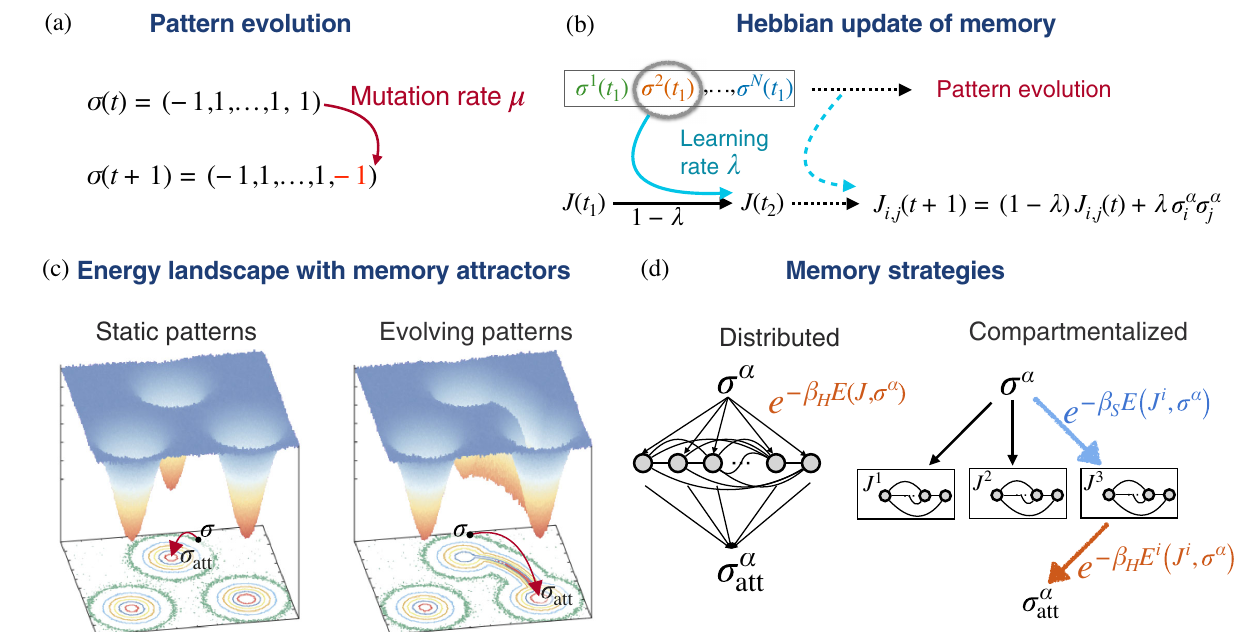
FIG. 1. Model of working memory for evolving patterns. (a) The targets of recognition are encoded by binary vectors f σ g of length L . Patterns can evolve over time with a mutation rate μ denoting the fraction of spin flips in a pattern per network update event. (b) Hebbian learning rule is shown for a network J , which is presented a set of N patterns f σ α g (colors) over time. At each step, one pattern σ α is randomly presented to the network, and the network is updated with learning rate λ [Eq. (2)]. (c) The energy landscape for networks with distributed memory with optimal learning rate for static (left) and evolving (right) patterns are shown. The equipotential lines are shown in the bottom 2D plane. The energy minima correspond to memory attractors. For static patterns (left), equilibration in the network ’ s energy landscape drives a pattern toward its associated memory attractor, resulting in an accurate reconstruction of the pattern. For evolving patterns (right), the heightened optimal learning rate of the network results in the emergence of connecting paths (mountain passes) between the energy minima. The equilibration process can drive a pattern through a mountain pass toward a wrong memory attractor resulting in pattern misclassification. (d) A network with distributed memory (left) is compared to a specialized network with multiple compartments (right). To find an associative memory, a presented pattern σ α with energy E ð J; σ α Þ in network J equilibrates with inverse temperature β in the network ’ s energy landscape and falls into an energy attractor σ α . Memory retrieval is a two-step H att ∼ exp ½ − β E i ð J i ; σ α Þ(cid:3) , where β process in a compartmentalized network (right): First, the subnetwork J i is chosen with a probability P i S S is the inverse temperature for this decision. Second, the pattern equilibrates within the subnetwork and falls into an energy attractor σ α att